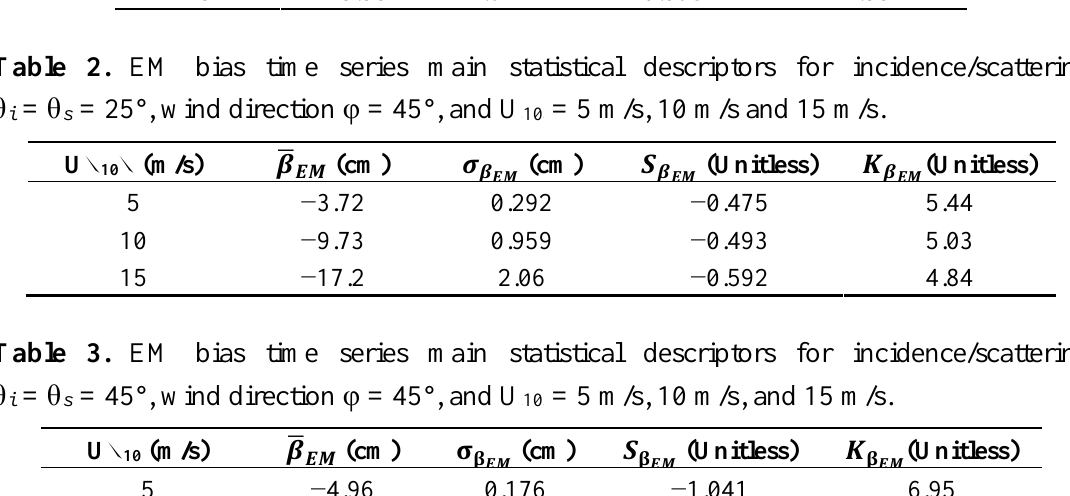
= 5 m/s, 10 m/s, and 15 10 R R